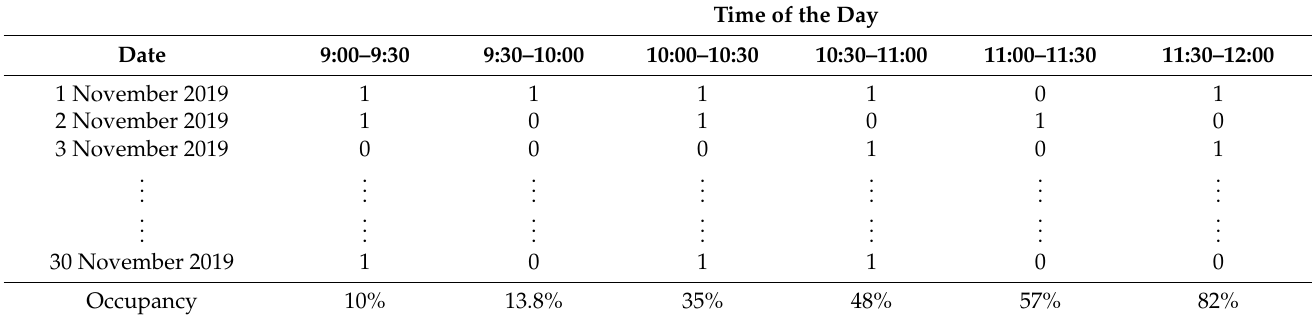
Table 1. Method of analysis for monthly occupancy averages for specific time intervals (1: occupied, 0: